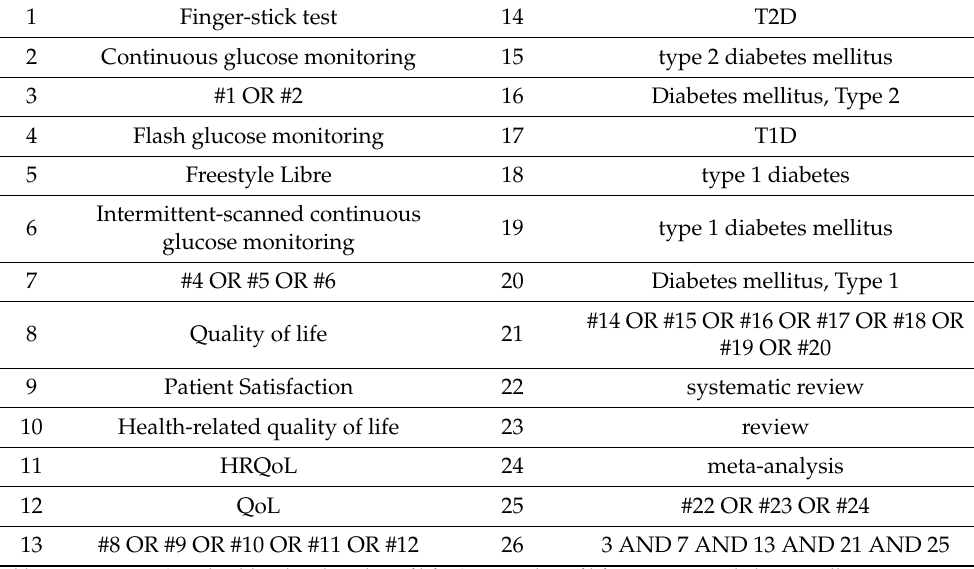
Table 1. Search strategy for